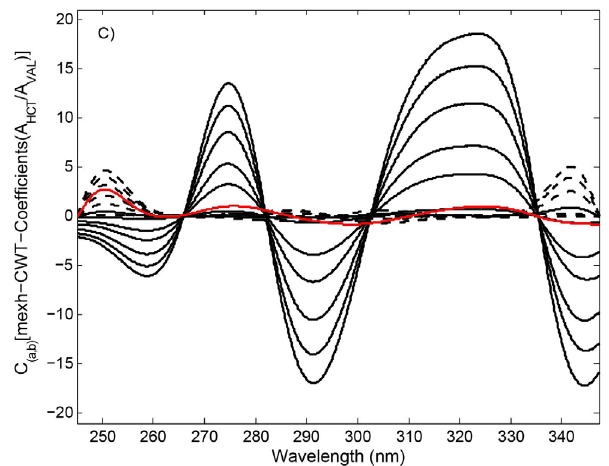
FIGURE 4C - RS-mexh-CWT spectra of VAL (----) : 1.0, 3.0, 9.0, 15.0, 21.0, 27.0, 33.0 µ g/mL and HCT (  ) : 1.0, 6.0, 11.0, 16.0, 21.0, 26.0 µ g/mL and tablet sample (  ) containing 2.50 µ g/mL of VAL and 16.0 µ g/mL of